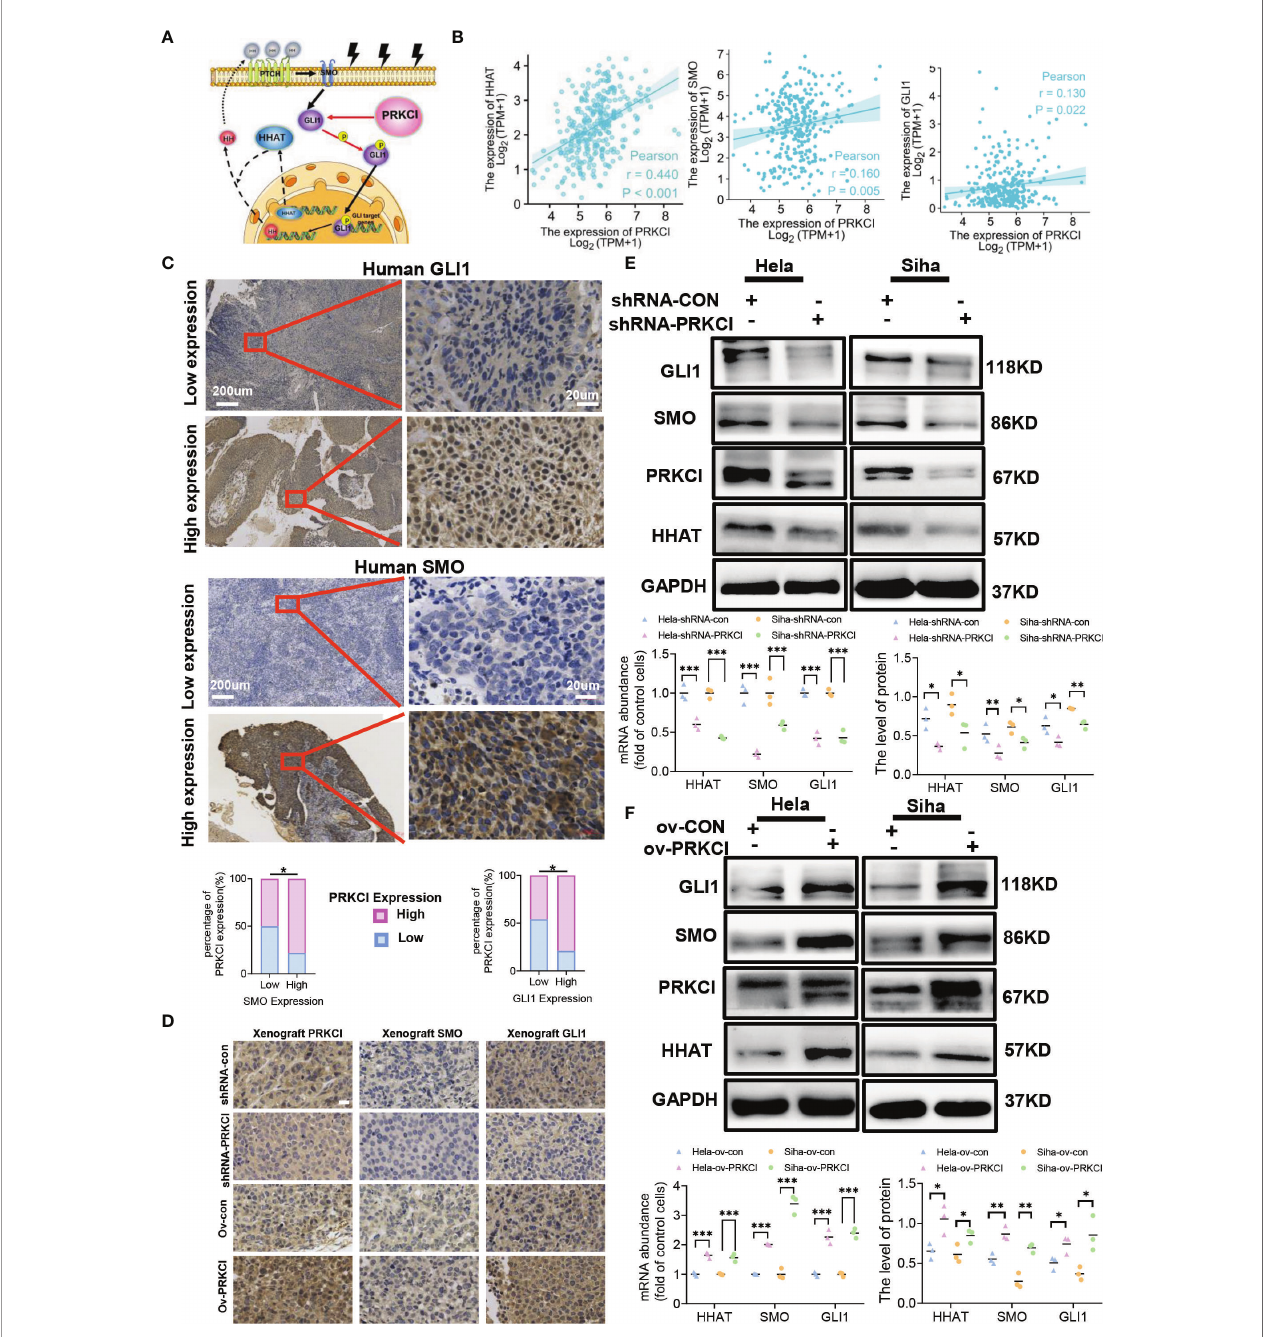
FIGURE 5 | PRKCI mediated radiosensitivity in CC via the Hedgehog signaling pathway. (A) Schematic of the PRKCI and Hh signaling transduction pathways. (B) The association between PRKCI mRNA levels and HHAT, SMO, and GLI1 levels in CC samples (n = 306, TCGA dataset). (C) Representative images (×50 and ×400) of IHC staining for SMO and GLI1 in 60 CC patients who underwent radical radiotherapy (high expression vs. low expression). Correlation analysis for PRKCI, SMO, and GLI1 in patients (n = 60). (D) Representative images of PRKCI (×400), SMO (×400), and GLI1 (×400) staining of the xenografts from different groups; scale bar = 20 µm. (E) HeLa and SiHa cells were transfected with empty vector (GV248) or vector containing PRKCI shRNA and treated with radiation. The mRNA and protein levels of HHAT, SMO, and GLI1 are presented. (F) HeLa and SiHa cells were transfected with empty vector (GV358) or vector containing PRKCI and treated with radiation. The mRNA and protein levels of HHAT, SMO, and GLI1 are presented. Scale bars are shown. p-Values were calculated by Pearson ’ s test (B) . Data are shown as the mean ± SD from three independent experiments. *p < 0.05; **p < 0.01; ***p < 0.001 by chi-square tests (C) , by multiple t-tests (E, F) . CC, cervical cancer; TCGA, The Cancer Genome Atlas; IHC,